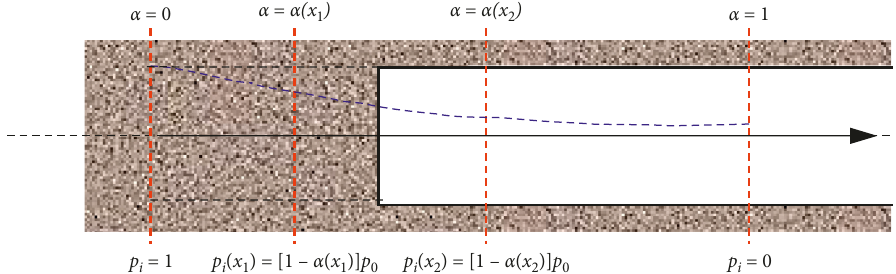
Figure 1: Space constraint effects of working force on different